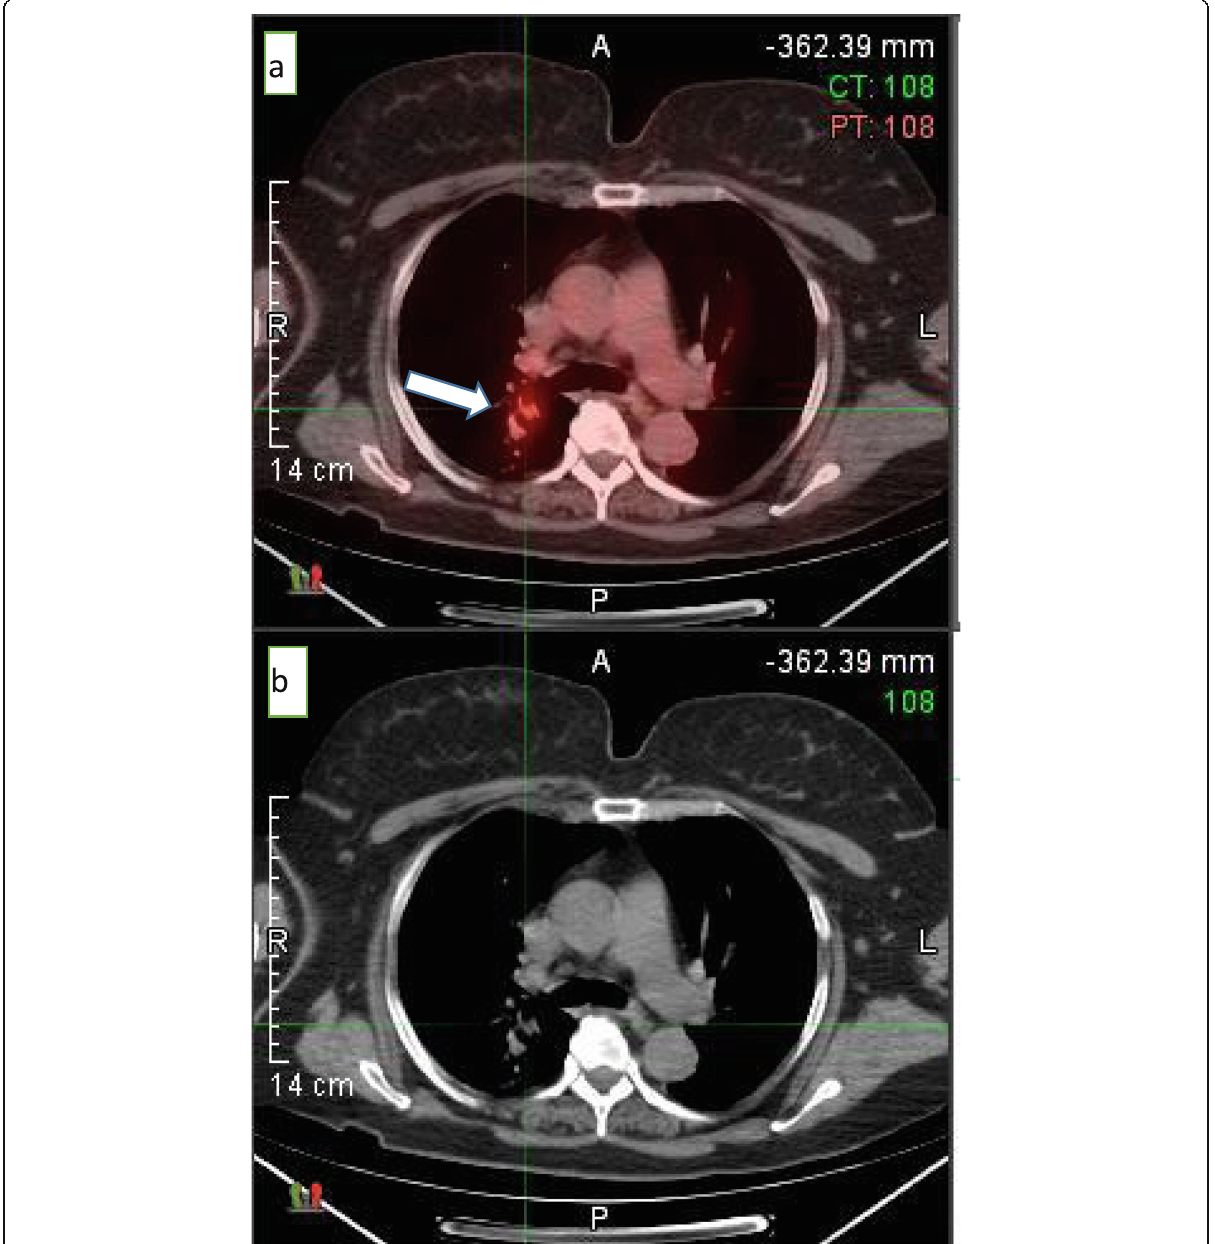
Fig. 1 ( a - b ) 56-year-old female with recurrent lung carcinoma 18F-FDG PET/CT was performed 1 year post treatment, revealed 3.2 cm AP×2.7 cm wide FDG avid mass (SUV max 3.4) in the posterior segment of right upper lung lobe (arrow). Right retrocaval pretracheal lymph node with low- grade activity tumor bearing lymph node was noted ( a ). CT imaging revealed atelectasis and/or pneumonitis measuring 3.2 cm AP×2.7cm wide at the posterior segment of right upper lung lobe with no metastatic lymphadenopathy detected ( b